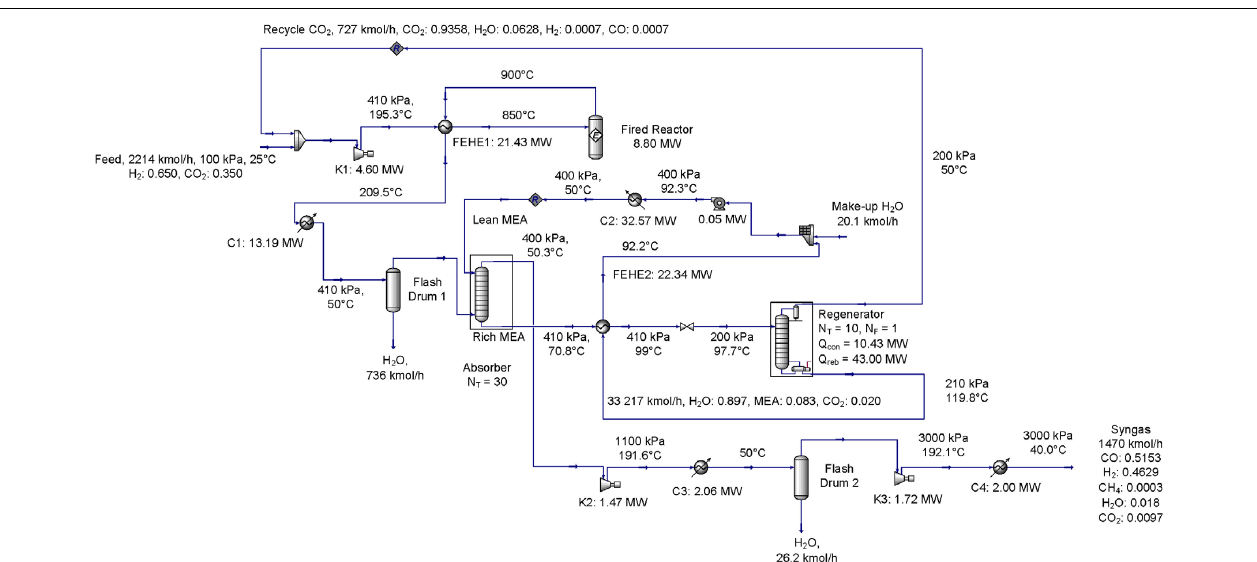
FIGURE 5 | The model used for the RWGS reaction based on Rezaei and Dzuryk (2019), adjusted to meet the requirements of the existing process. The flow compositions are on a molar basis.